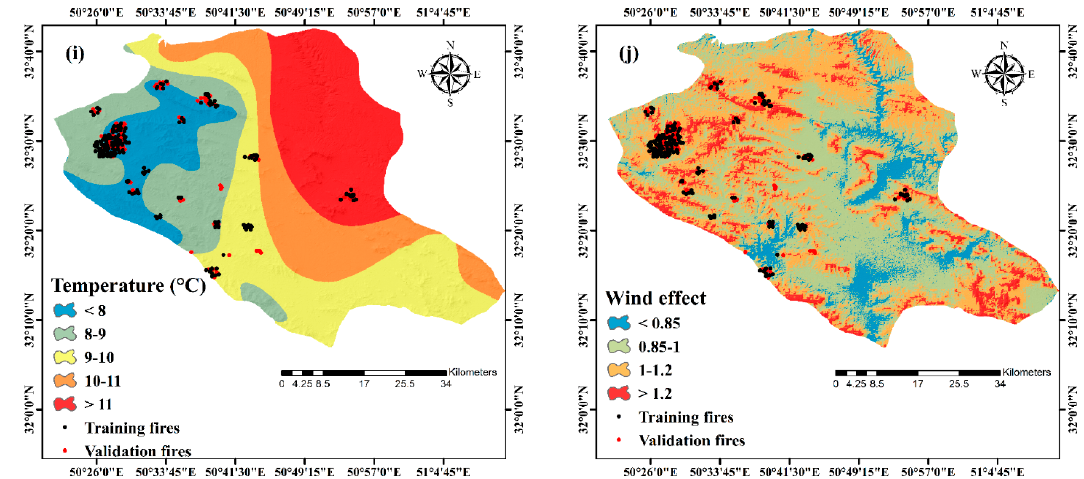
Figure 3. Forest fire effective criterion: (a) the altitude; (b) the slope angle; (c) the slope aspect; (d) the land use/cover; (e) the soil; (f) the distance to roads; (g) the distance to settlements; (h) the rainfall; (i) the temperature and (j) the wind effect.